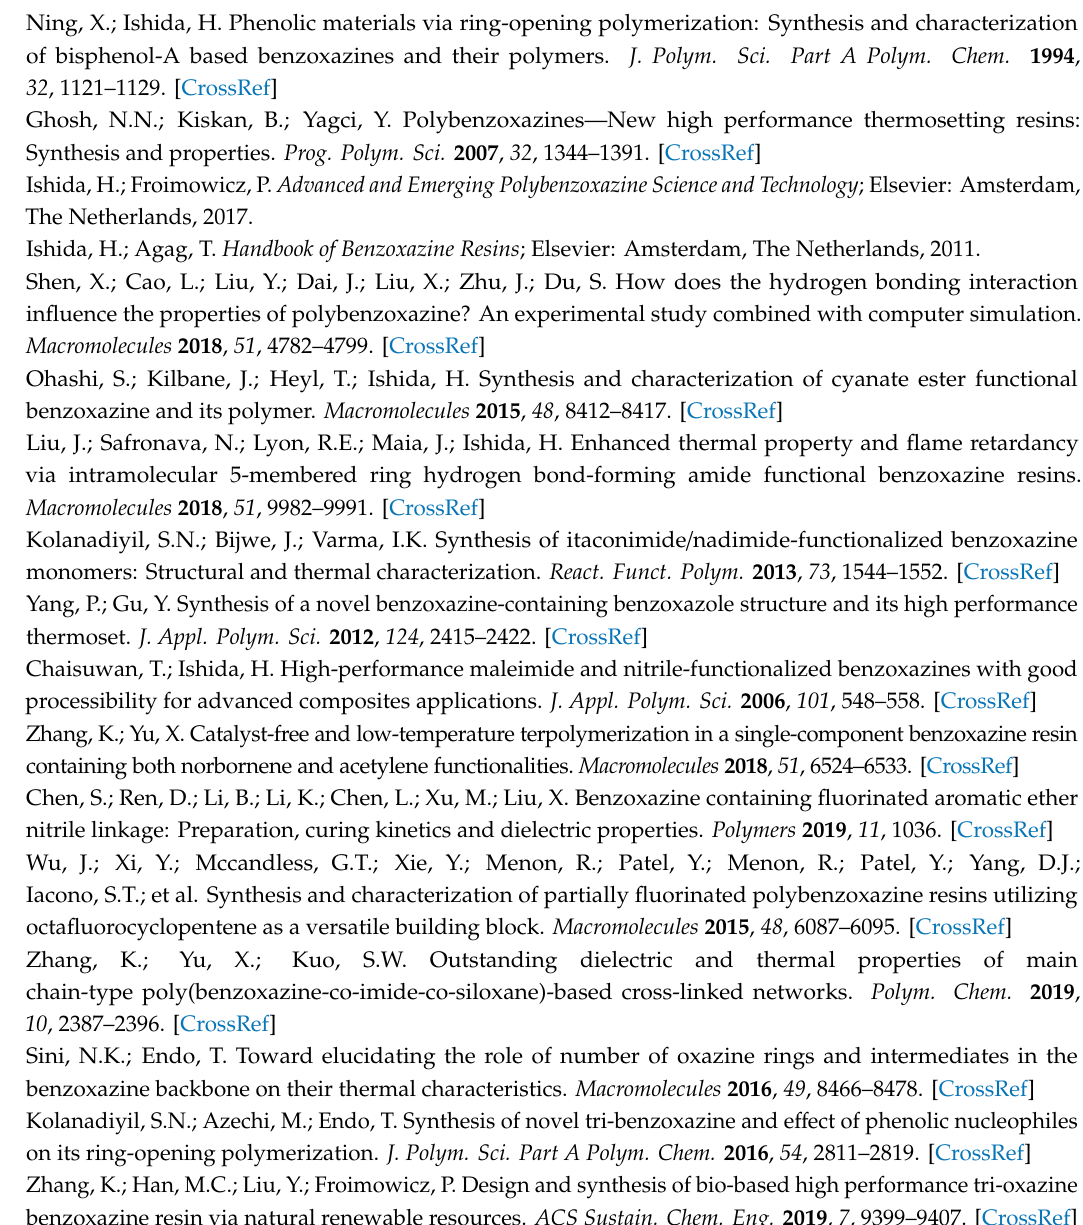
Figure S1: 1 H- 1 HNOESY 2D NMR spectrum of RES-al, Figure S2: 1 H-13C HMQC 2D NMR spectrum of